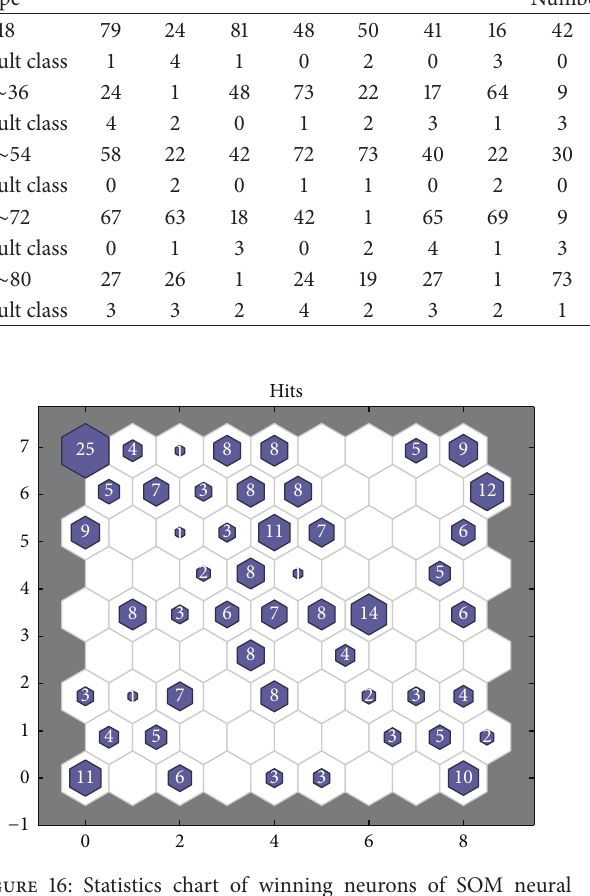
Figure 16: Statistics chart of winning neurons of SOM neural network optimized by PSO algorithm.